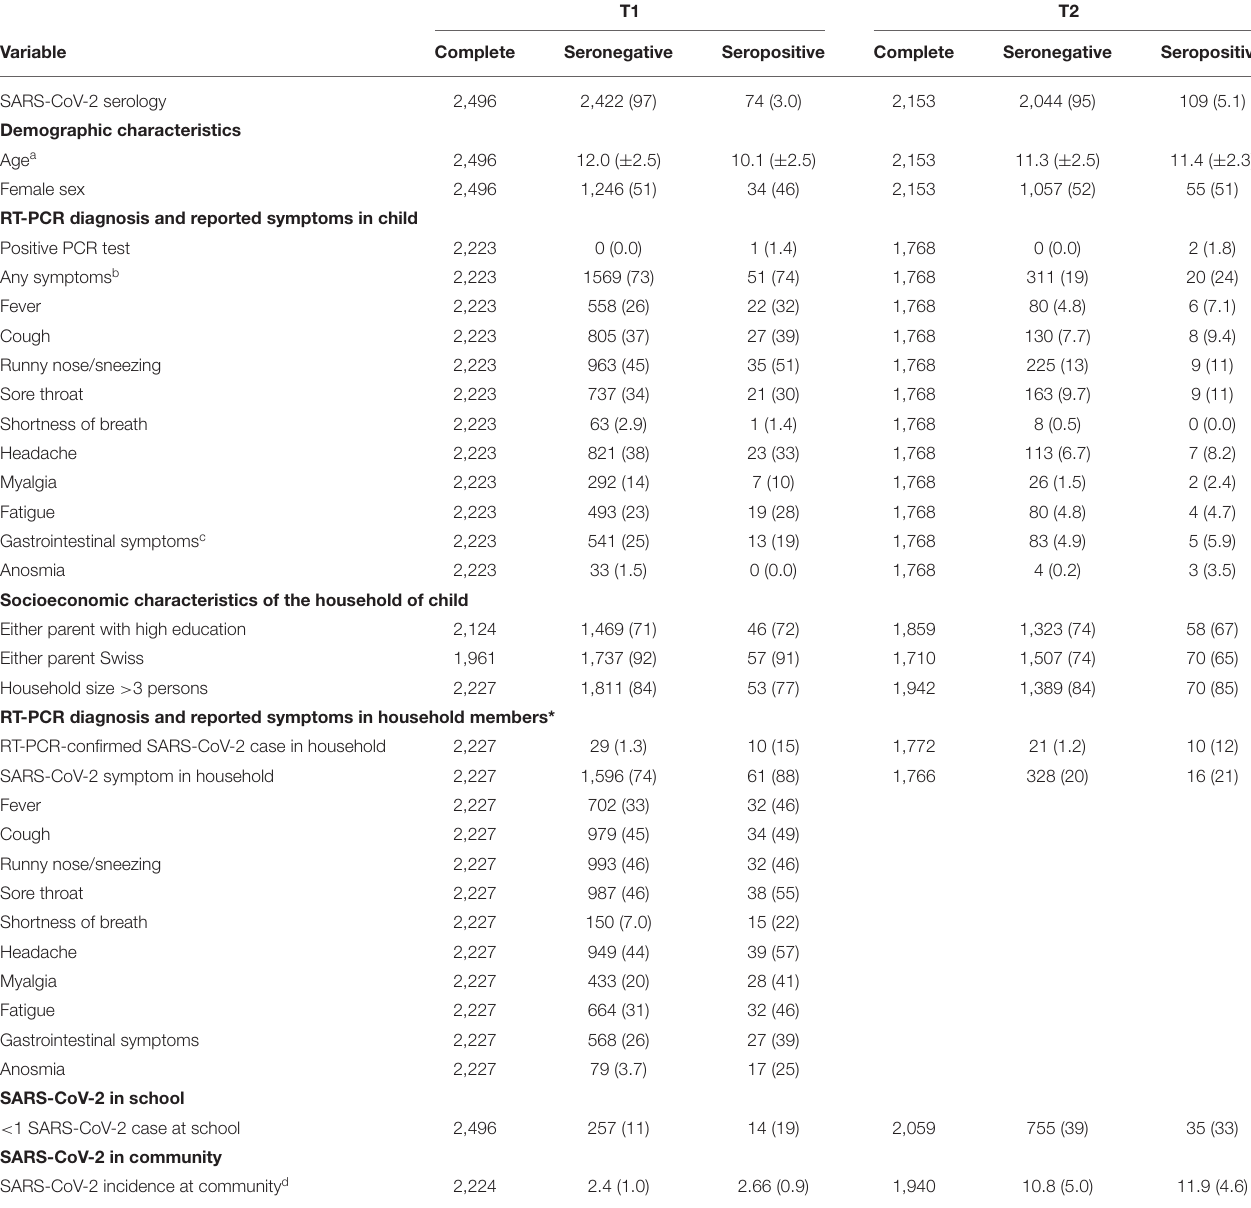
TABLE 1 | Demographics, symptoms, and exposure information in seronegative and seropositive children.